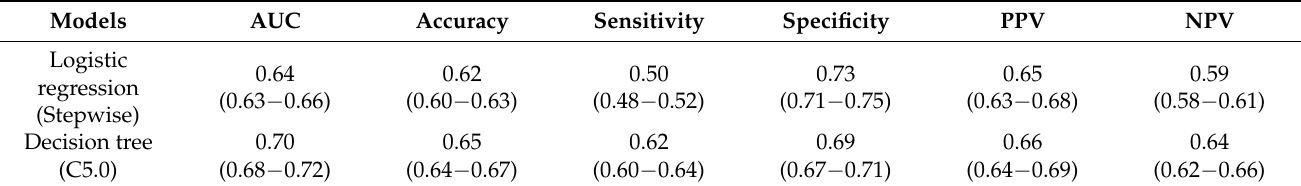
Table 4. Model performance of logistic regression and decision tree for fall